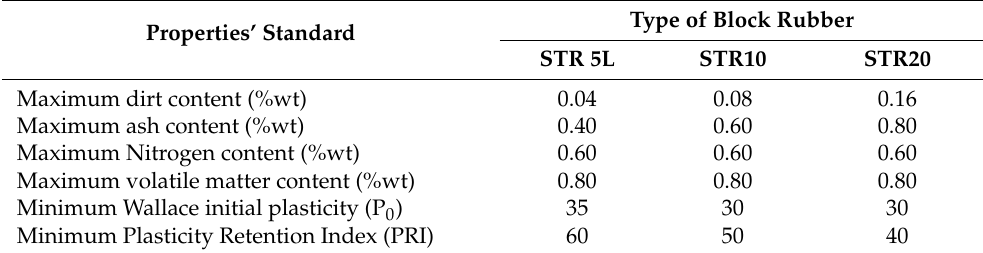
Table 1. The properties’ standard for STR 5L, STR 10 and STR20 block rubber.